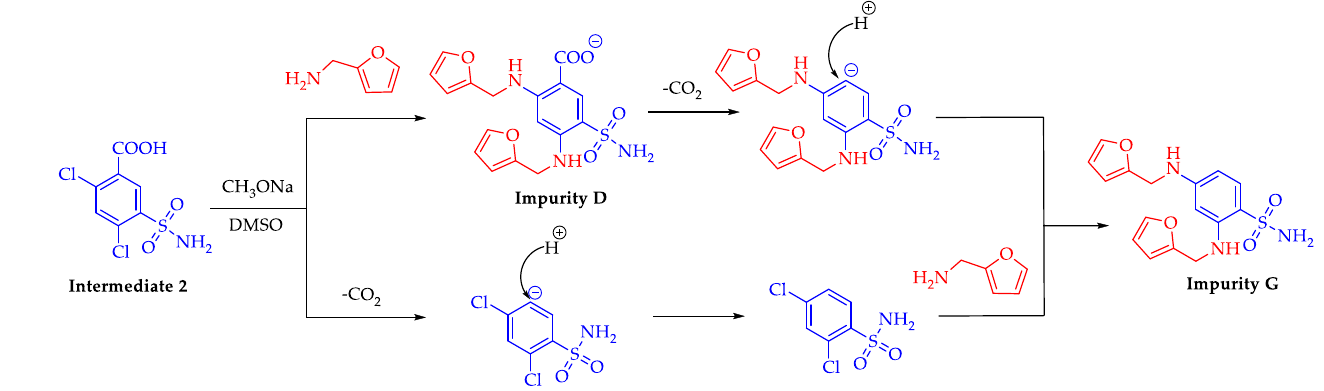
Figure 4. Plausible mechanism for the formation of impurity G.